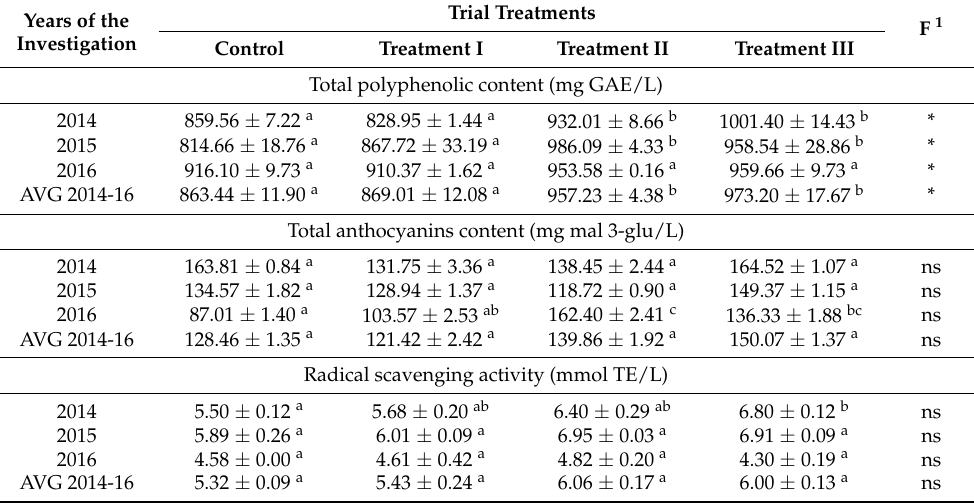
Table 2. Total polyphenolic content, radical scavenging activity and total anthocyanins content of